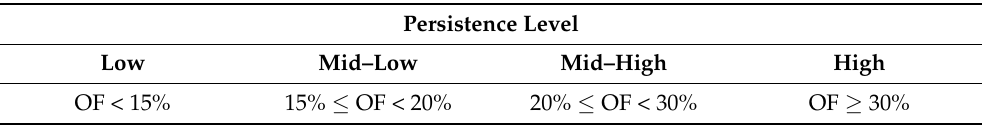
Table 3. Criteria of the persistence classes, predicted from the 25th (Q1), 50th (Q2) and 75th (Q3) quartiles of OFs.